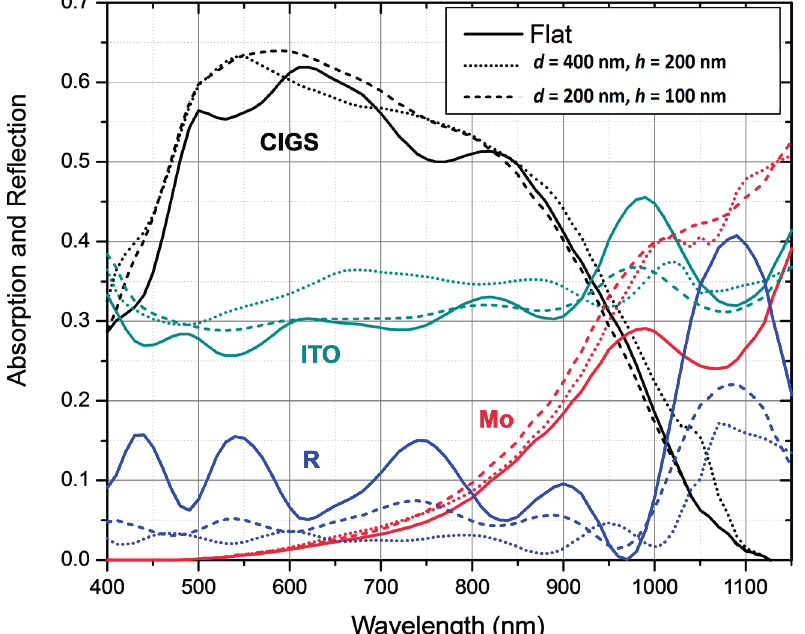
Figure 5. Absorption in individual solar cell layers (ITO, CIGS and Mo) as well as total reflection from the surface of the cell. The results are shown for flat cell, and two textured cells with different texture size ( d = 400 nm and h = 200 nm; d = 200 nm and h = 100 nm). Absorption within the buffer layer (CdS) is not displayed since its change with the variation of texturing dimensions is very